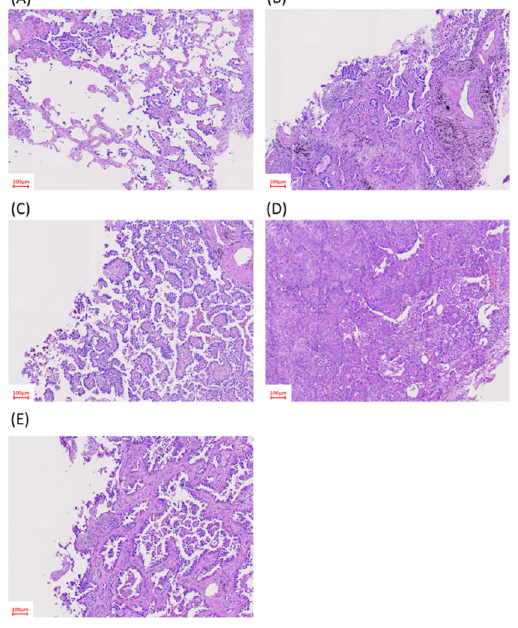
Figure 2. Histological patterns of lung adenocarcinoma. Representative hematoxylin and eosin-stained biopsy specimens: ( A ) lepidic-predominant pattern; ( B ) acinar-predominant pattern; ( C ) papillary-predominant pattern; ( D ) solid-predominant pattern; and ( E ) micropapillary-predominant pattern.